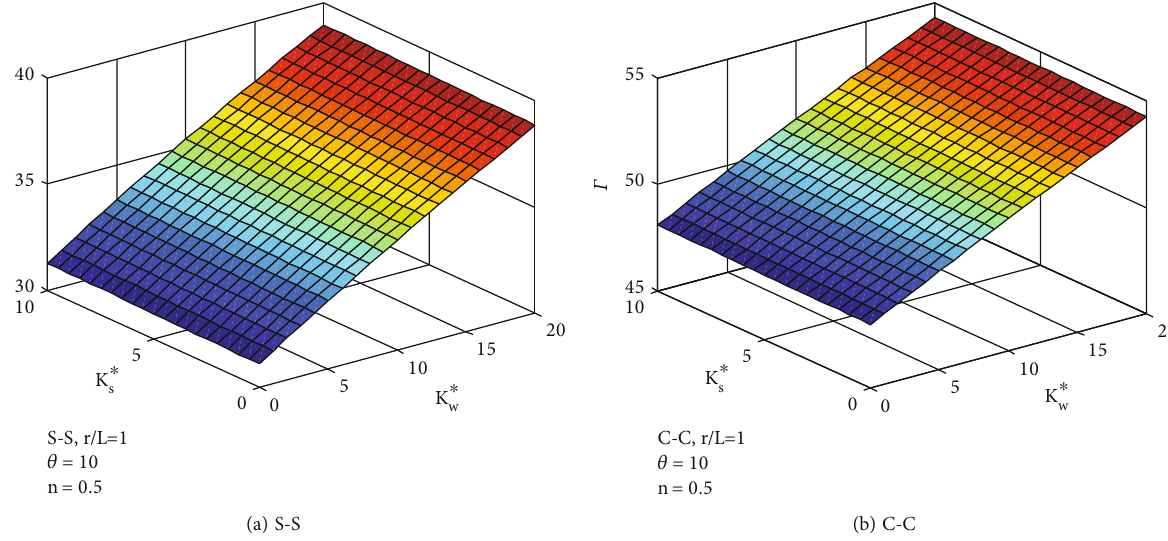
K ∗ h / h a = 10 . w and s and